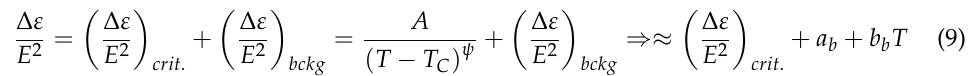
where ‘ crit. ’ is for the critical contribution and ‘ bckg ’ is for the molecular background effect. Generally, the background effect is related to various complex molecular mecha- nisms [110,126,127]. However, in any case, a linear approximation in a limited range of temperatures is possible, as indicated in Equation (9).